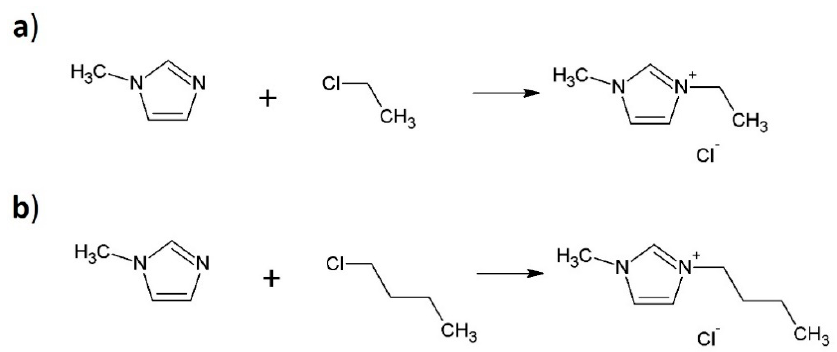
Figure 7. Synthesis of 1-ethyl-3-methylimidazolium chloride ( a ) [EMIM][Cl] and ( b ) 1-propyl-3- methylimidazolium chloride [PMIM][Cl].